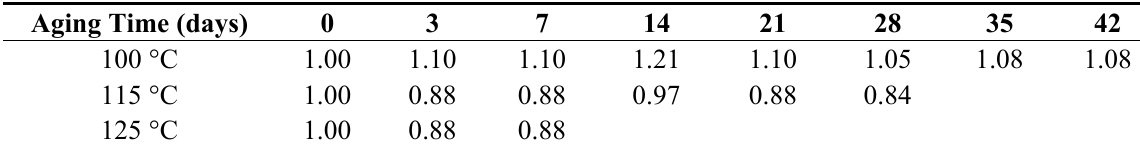
Table A8. Tensile strength of the nanolayered film with 4,094 layers of 31-nm thick (Type 4 film in Table 2) aged at temperatures of 100 °C, 115 °C and 125 °C. The data were normalized by the pristine material properties.